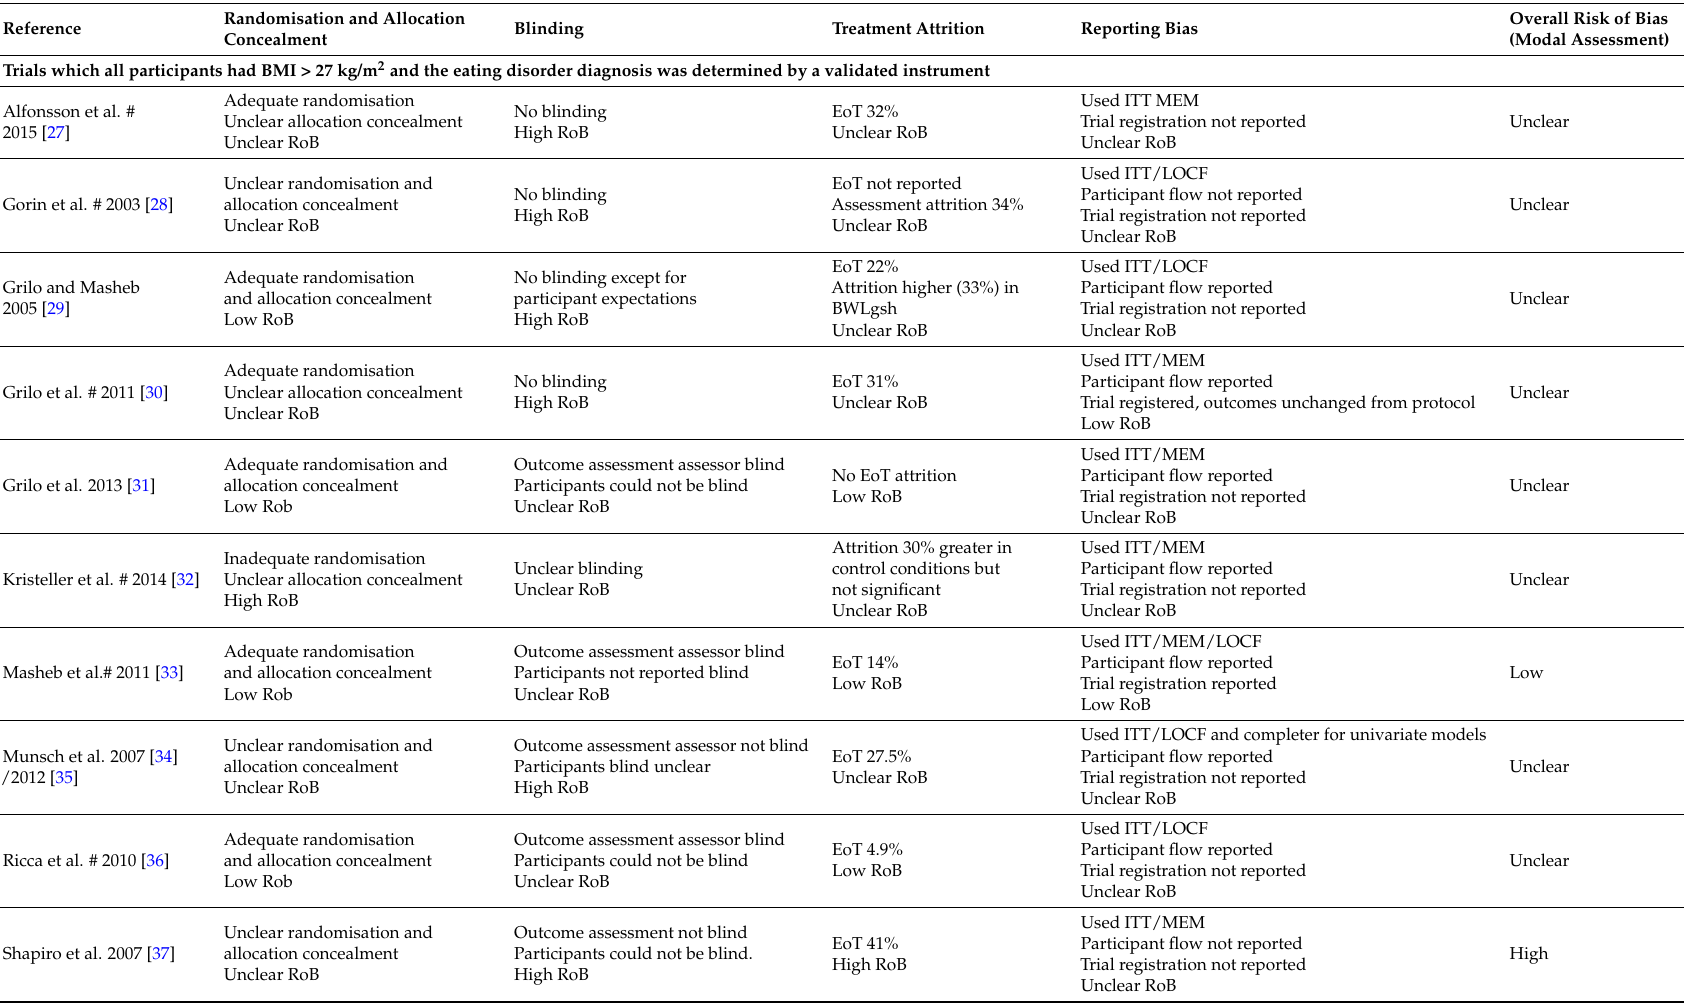
Table 2. Quality appraisal of the nineteen included